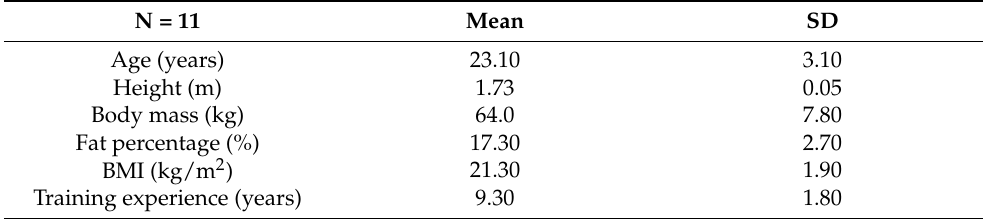
Table 1. Characteristics of highly trained female volleyball players. Data are presented as M ±